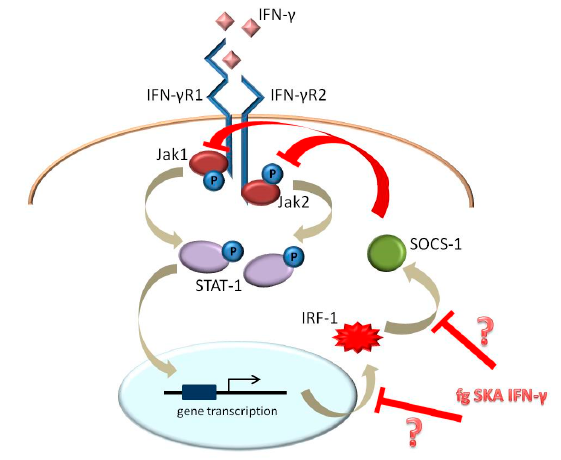
IFN- γ might induce intracellular signals that interfere with IRF-1 gene transcription or that reduce feedback, thus extending the duration of its action. (cid:0) means